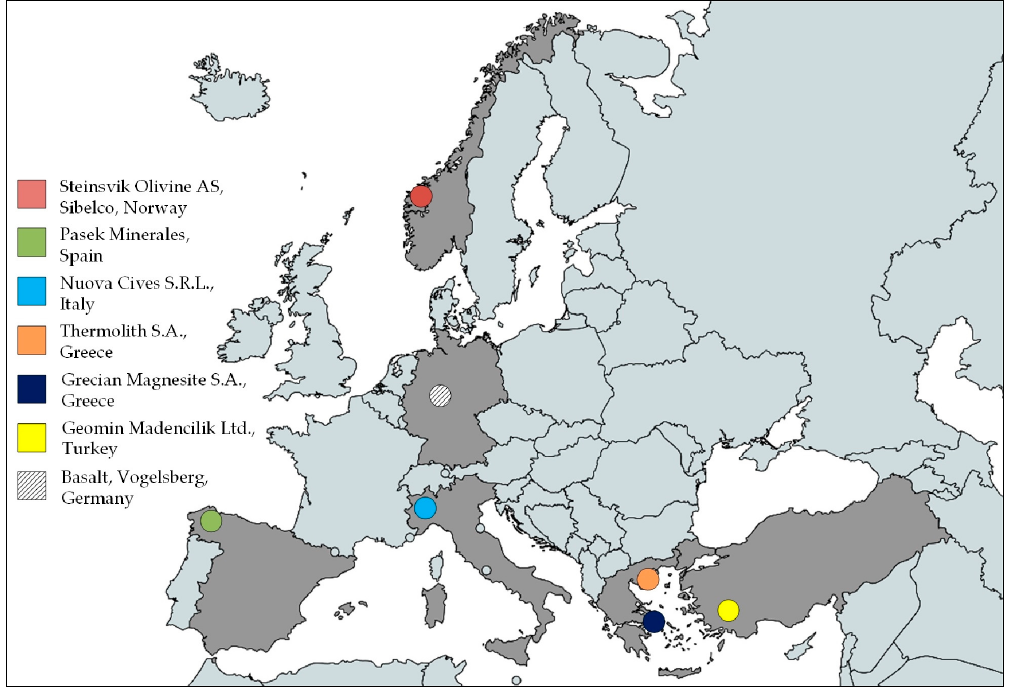
Figure 1. Origin of samples tested for the use in the carbonation process [8].